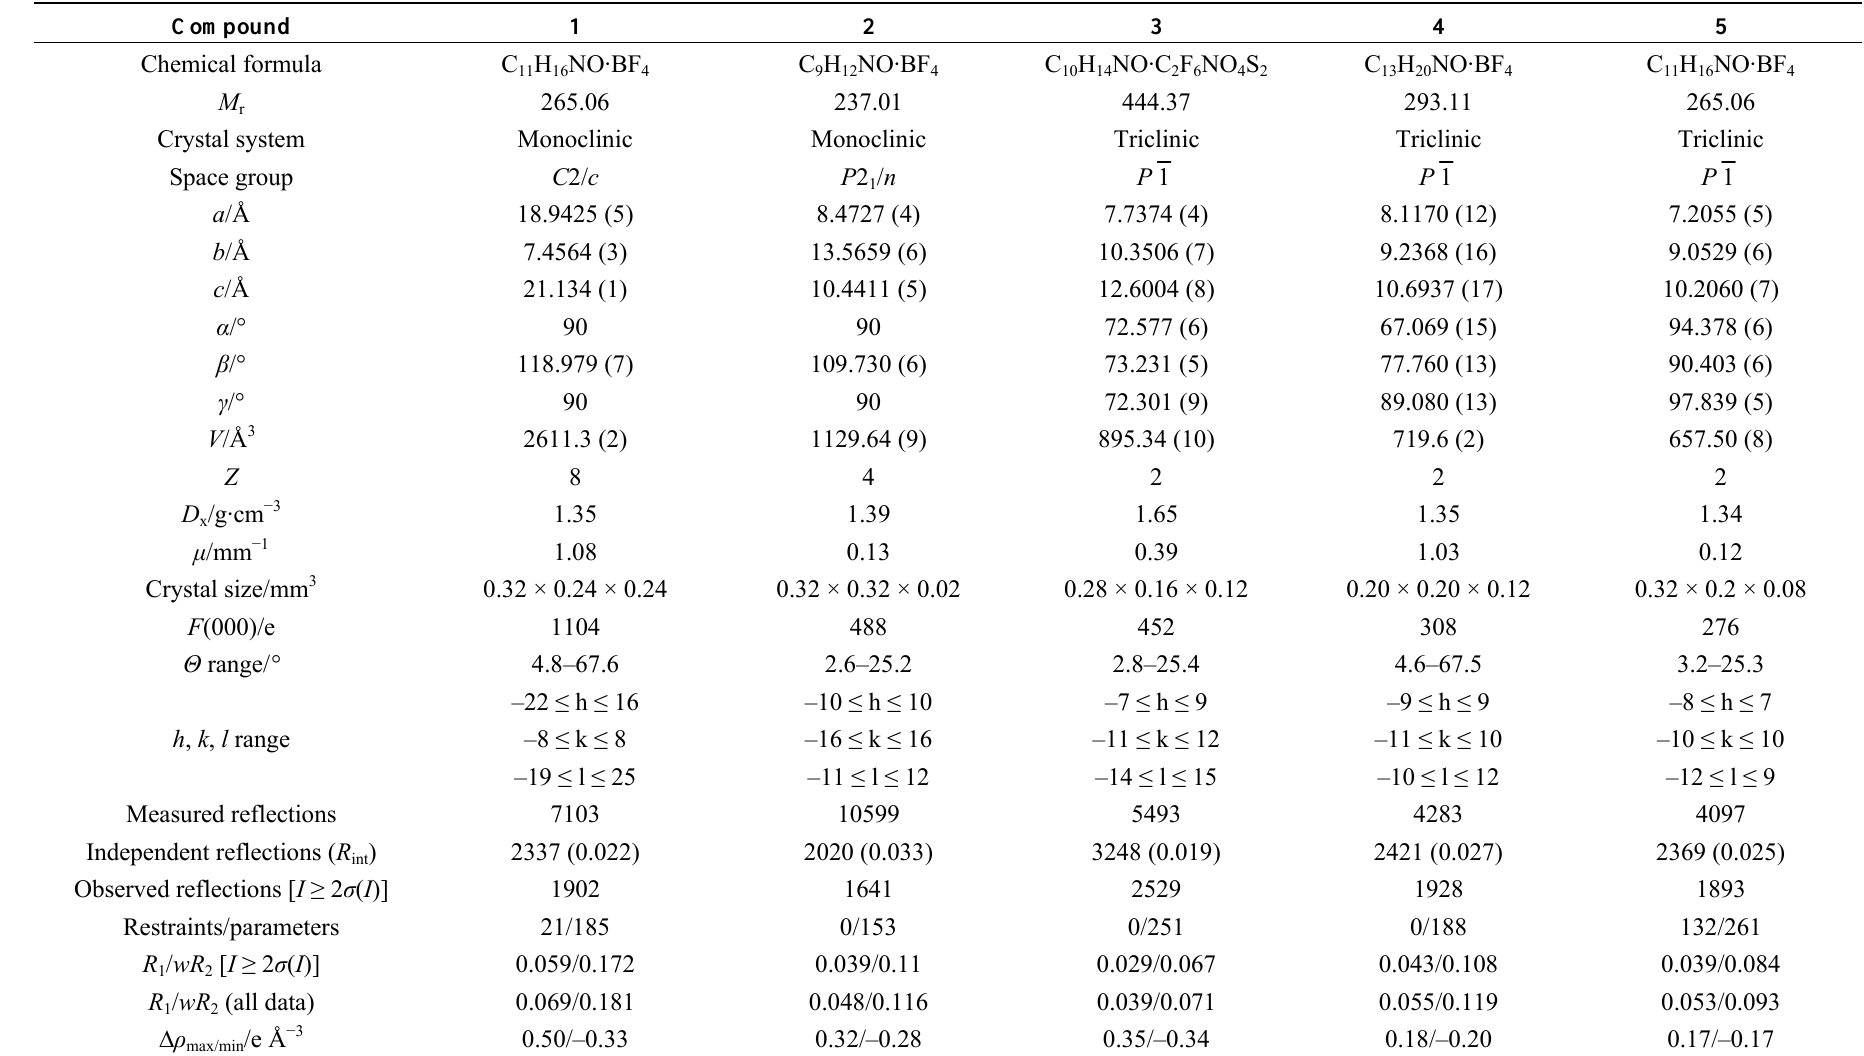
Table 1. Crystal data and structure refinement